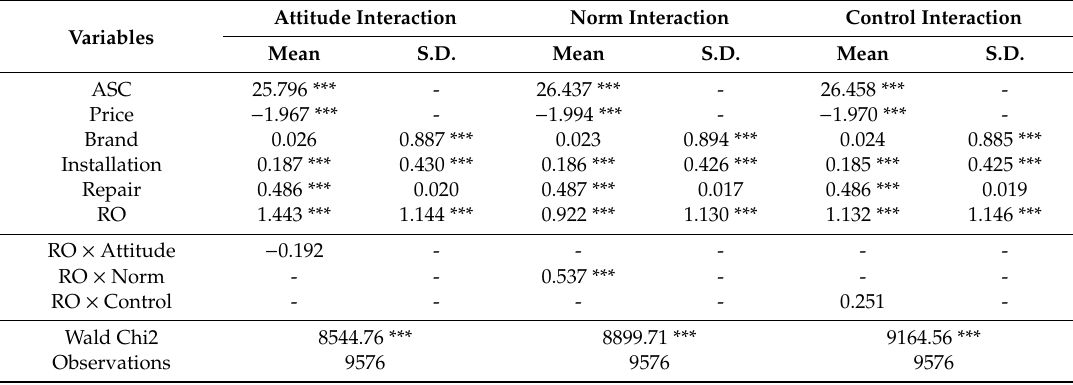
Table 12. The robustness check results of risk perception e ff